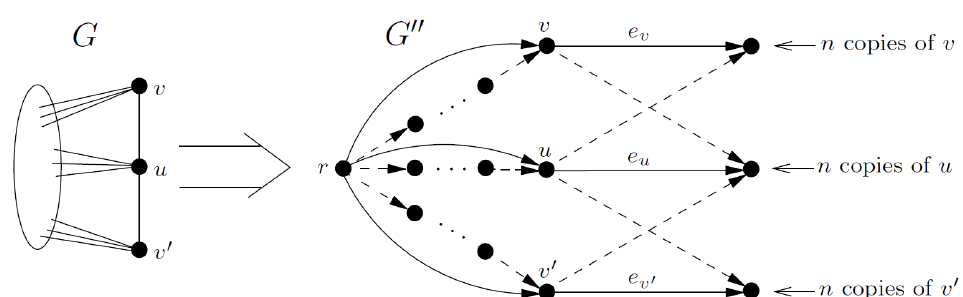
Figure 2. An example of the reduction defined in Theorem 2 for the graph G on the left side. The fixed-cost paths going from r to u , v , v (cid:48) contains n edges,